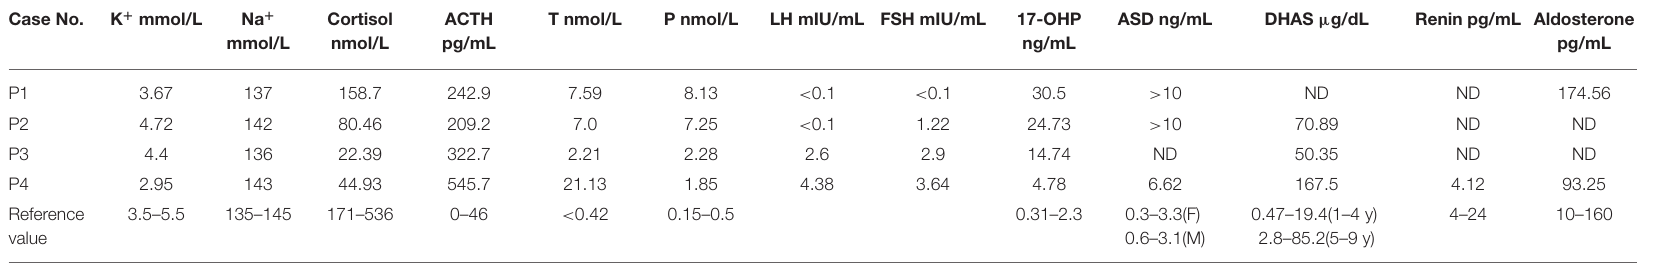
TABLE 2 | Biochemical characterization of four patients with 11 β OHD. Case